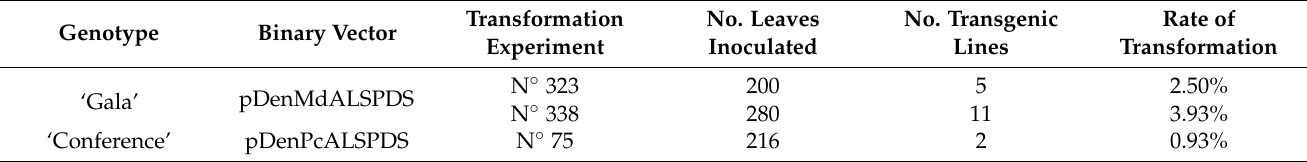
Figure 3. Cytidine deaminase base editing (CBE) of ALS and PDS genes in M. domestica and P. communis. ( A ) Position of each sgRNA ALS on gene (black) and on the acetolactate synthase domain for pear (orange) and apple (blue); ( B ) position of each sgRNA PDS on gene (black) and on the phytoene desaturase domain for pear (orange) and apple (blue); ( C ) single guide RNA for ALS gene in apple and pear; ( D ) single guide RNA for PDS gene in pear; ( E ) single guide RNAs for PDS gene in apple; Sanger sequencing results for the recovered lines are below C, D, E; ( F ) Rate of mutation type per sg_RNA; ( G ) MdPDS protein sequence prediction after stop codon creating by CBE, for apple and pear, marked in blue are the amino acids that are lost by the non-sense mutation and in bold is the M (methionine) showing the possible new start codon. Table 2. Production of transgenic lines by